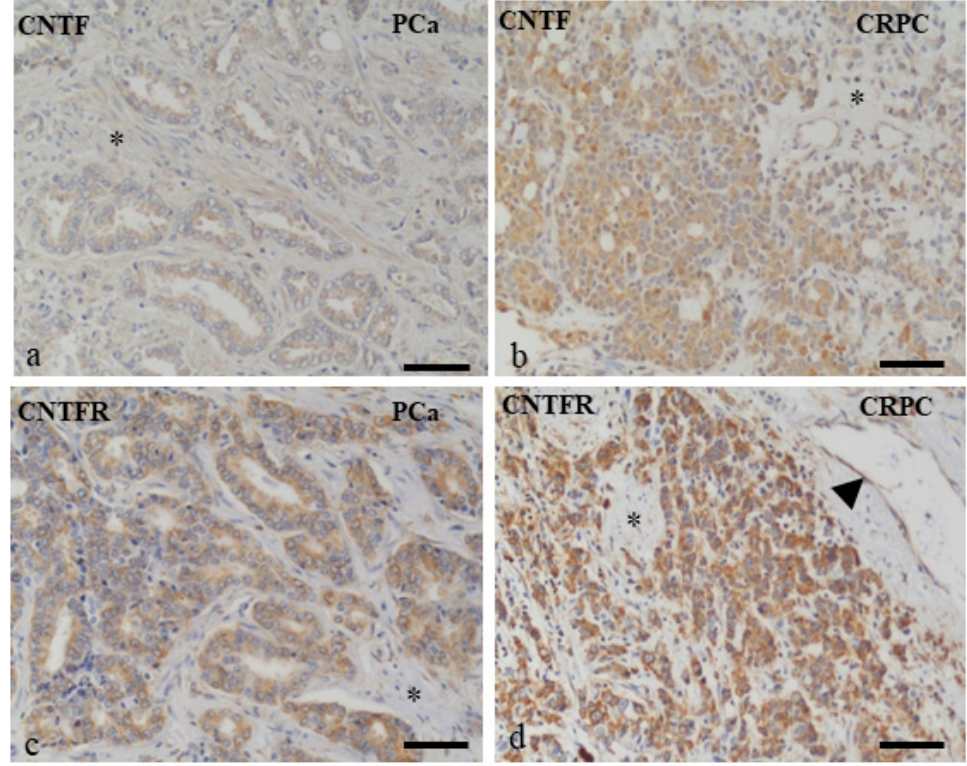
Figure 1. Immunohistochemistry localization of CNTF and CNTFR α in prostate cancer samples. CNTF ( a , b ) and CNTFR α ( c , d ) were expressed in PCa ( a , c ) and CRPC ( b , d ) tissues. Stromal components (*) were weakly positive for CNTF and mainly negative for CNTFR α . Endothelial cells (arrowhead in d) were positive or weakly stained for CNTFR α and CNTF, respectively. Scale bars: a,c = 100 μ m; d,b = 200 μ m.